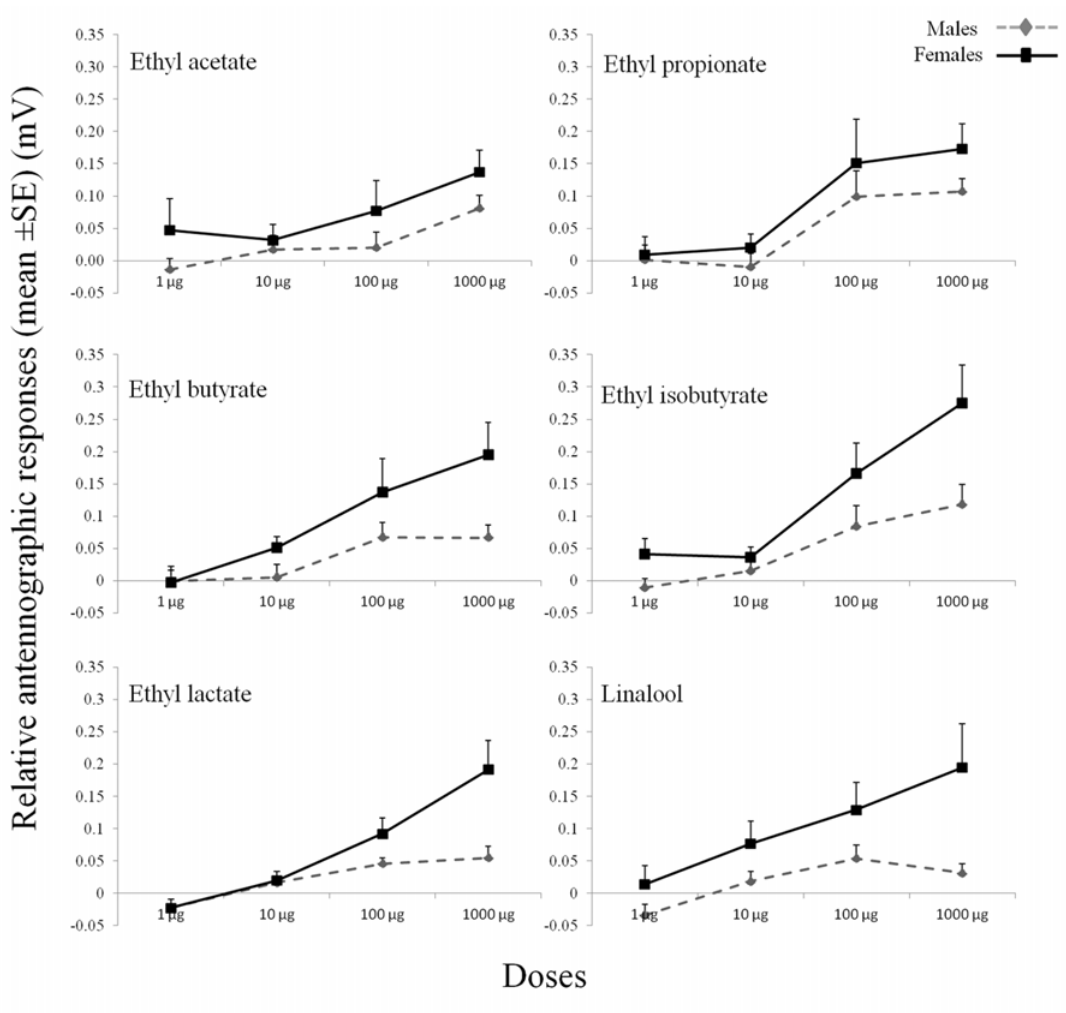
Fig 4. EAG dose — response curves for the antennae of Paysandisia archon males and females in response to the synthetic chemicals. EAG amplitudes were adjusted to the control stimulus (hexane), and are given as means ± SE. Each chemical was tested on six individuals of each